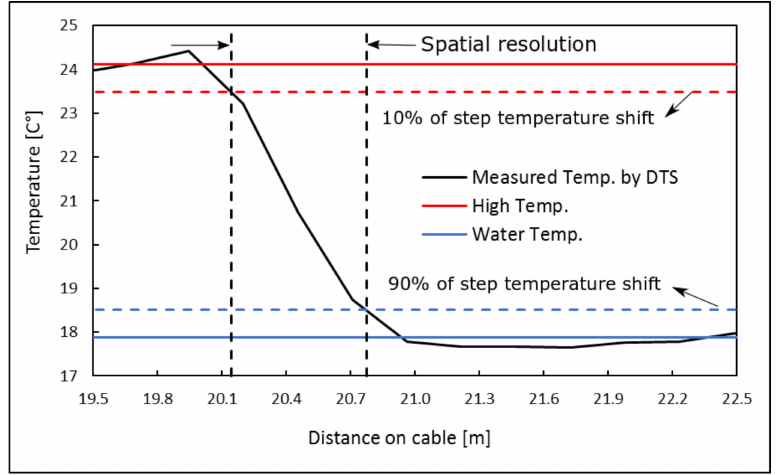
Figure 3. The spatial resolution of the Silixa XT-DTS